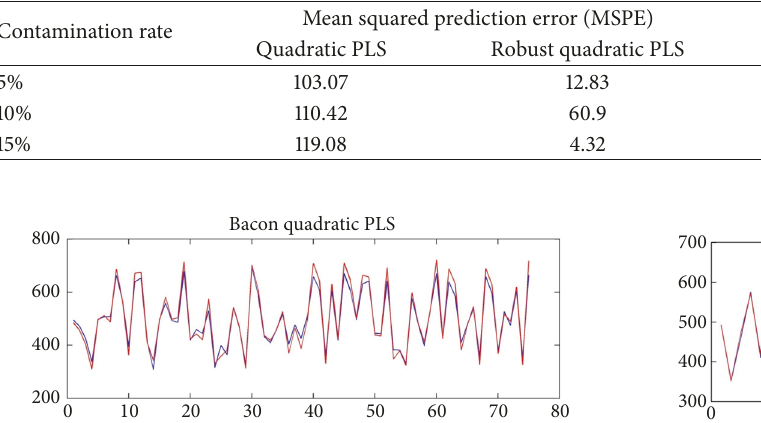
Table 3: Comparison between optimal mean squared prediction error and predictive error sum of squares of proposed quadratic algorithm and original one for simulated dataset with three contamination rates (5%, 10%, and 15%).